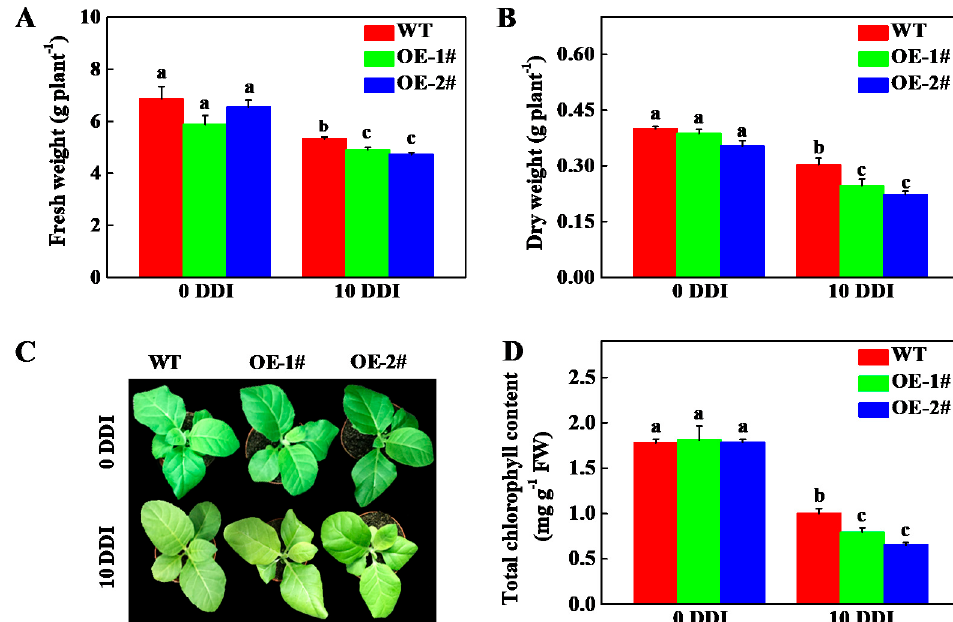
Figure 4. Analysis of dark-induced chlorophyll degradation of transgenic tobacco overexpression of CsHCAR . ( A ) Fresh weight; ( B ) dry weight; ( C ) tobacco seedlings phenotype; ( D ) Total chlorophyll content. The results represent the mean ± SE ( n = 3). Means with the same letter did not significantly differ at p < 0.05 according to Tukey’s test. WT, wild-type; OE- 1# and OE-2#, 2 independent transgenic tobacco overexpression of CsHCAR ; DDI, day(s) of dark incubation; FW, fresh weight.